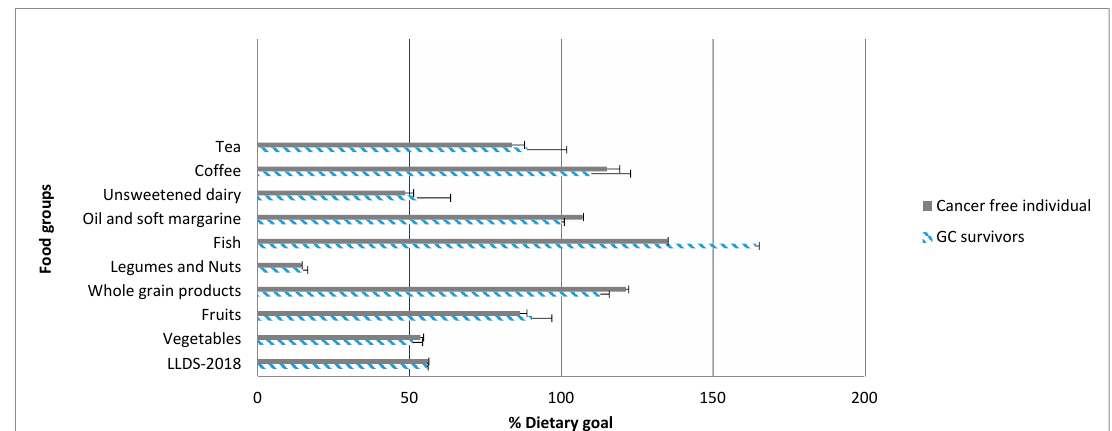
Figure 2. Adherence to dietary guidelines in terms of intake of foods with desired health effects in GI cancer survivors and the reference population in the Lifelines study, 2006–2016. The lengths of bars for each food component correspond to the mean intake divided by the recommended intake multiplied by 100. Recommended intake is based on the Dutch dietary guidelines published by Kromhout et al., 2015. Nutritional goals are set at 100 when the mean intake reaches the recommended intake. Abbreviation: GI, gastrointestinal.